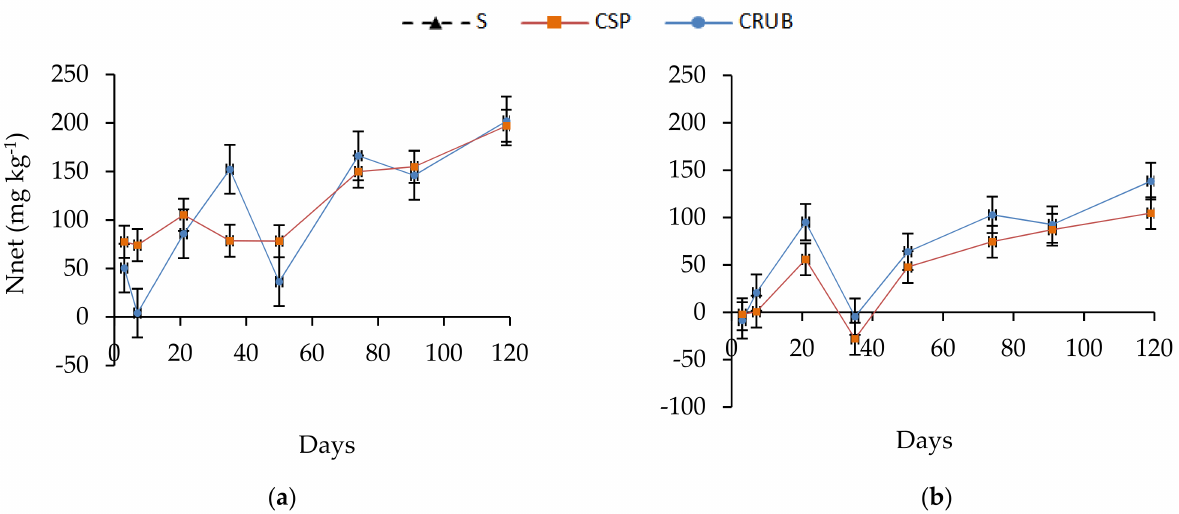
Figure 2. Potential net available N (Nnet). ( a ): S1; ( b ): S2. S: control; CSP: poultry manure and wheat straw; CRUB: biosolids and wood shavings. Bars represent standard error.